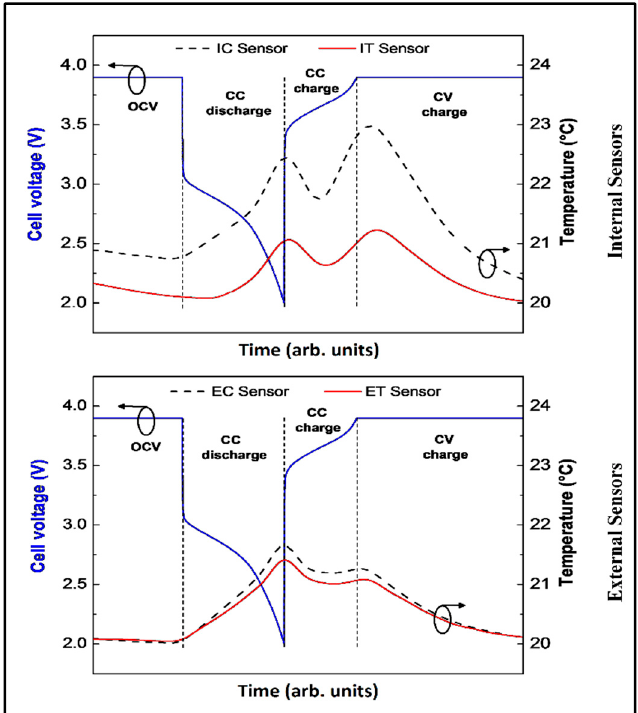
Figure 4. Temperature changes observed with the four sensors during cycling with a CC discharge followed directly by a CCCV charge (C-rate was 5C).